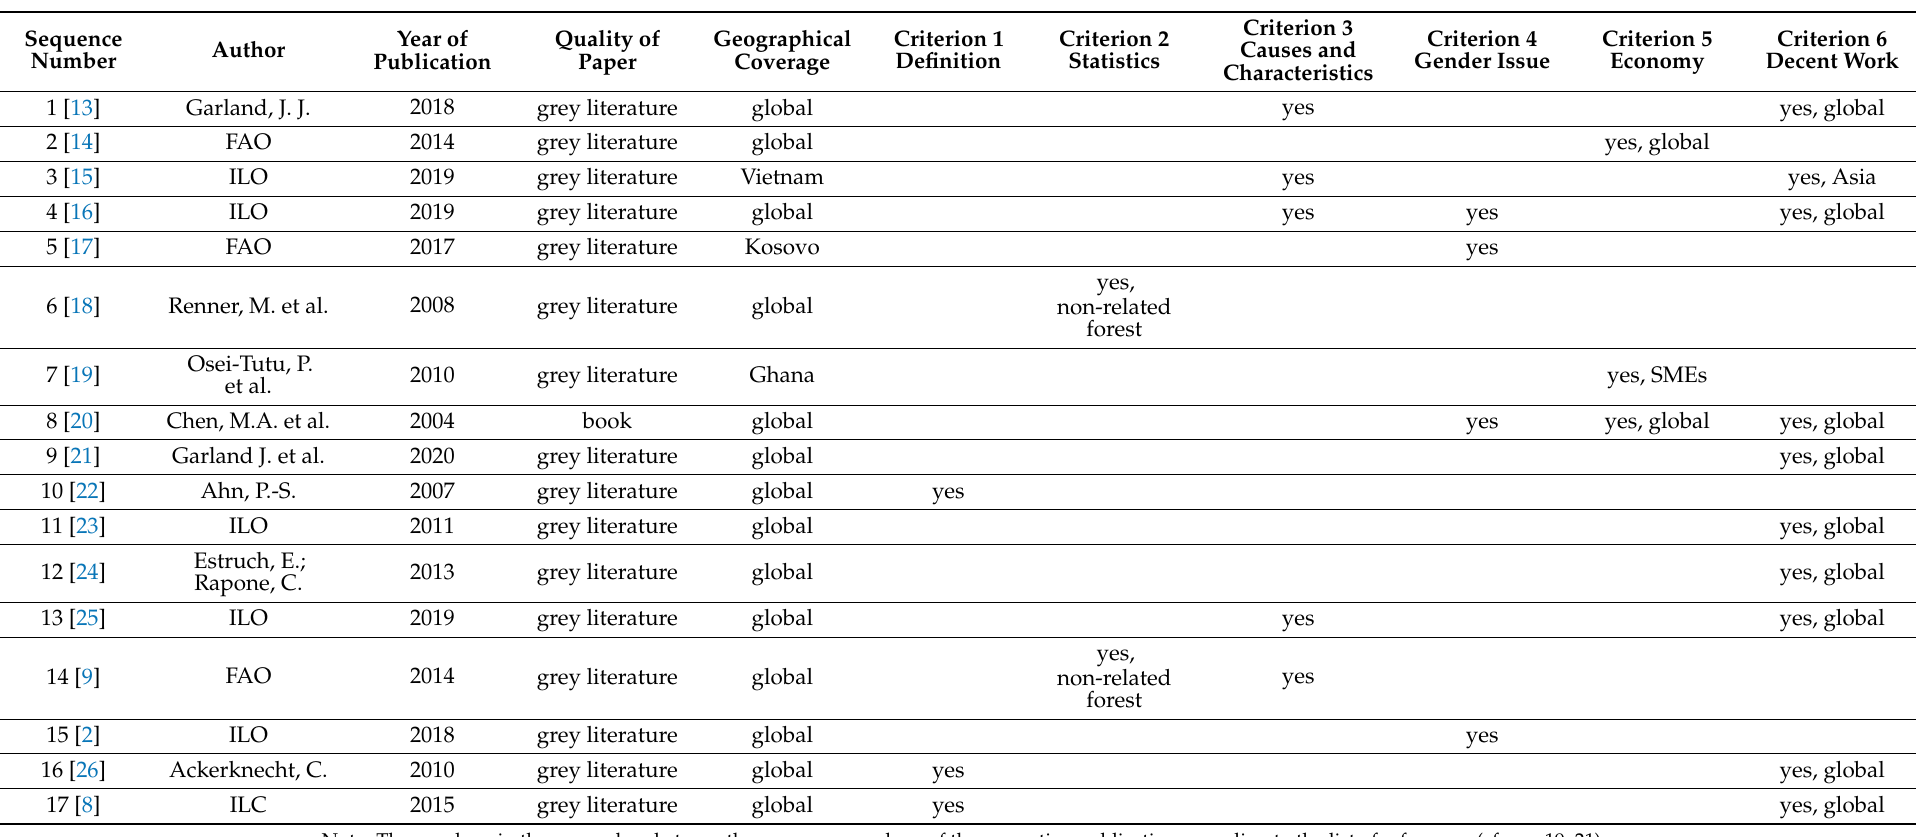
Table 1. Eligible literature after literature